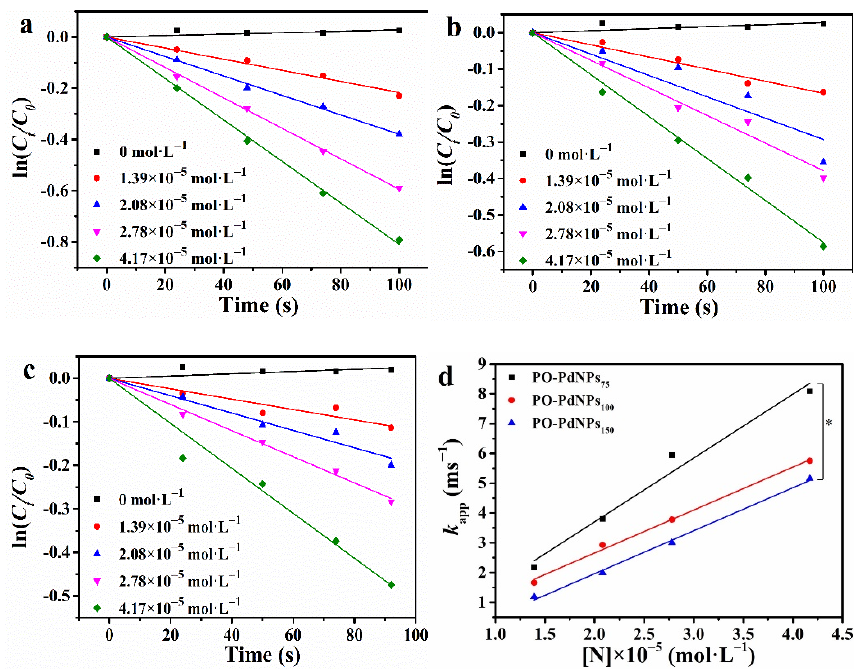
Figure 6. The catalytic process for ln( C t /C 0 ) and time ( a ) PO-PdNPs 75 , ( b ) PO-PdNPs 100 , ( c ) PO- PdNPs 150 , ( d ) the linear relationship between k app and concentration of PO-PdNPs n . * p < 0.05. Table 1. Comparison of K nor and TOF of PO-PdNPs n with other Pd-based catalysts in 4-NP reduc- tion.